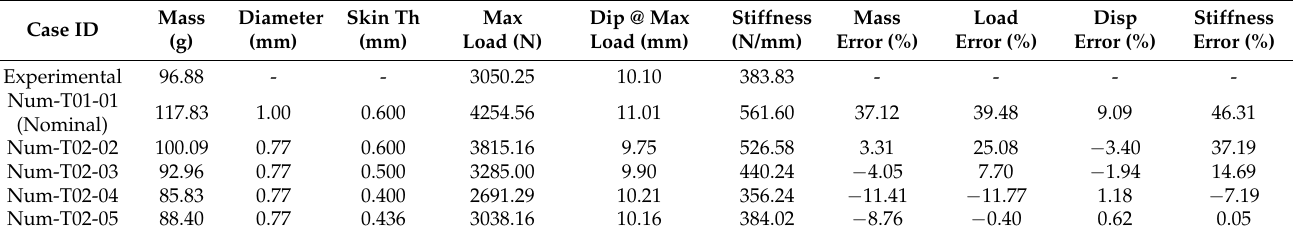
Table 5. Sensitivity analysis results -Specimen Type02.